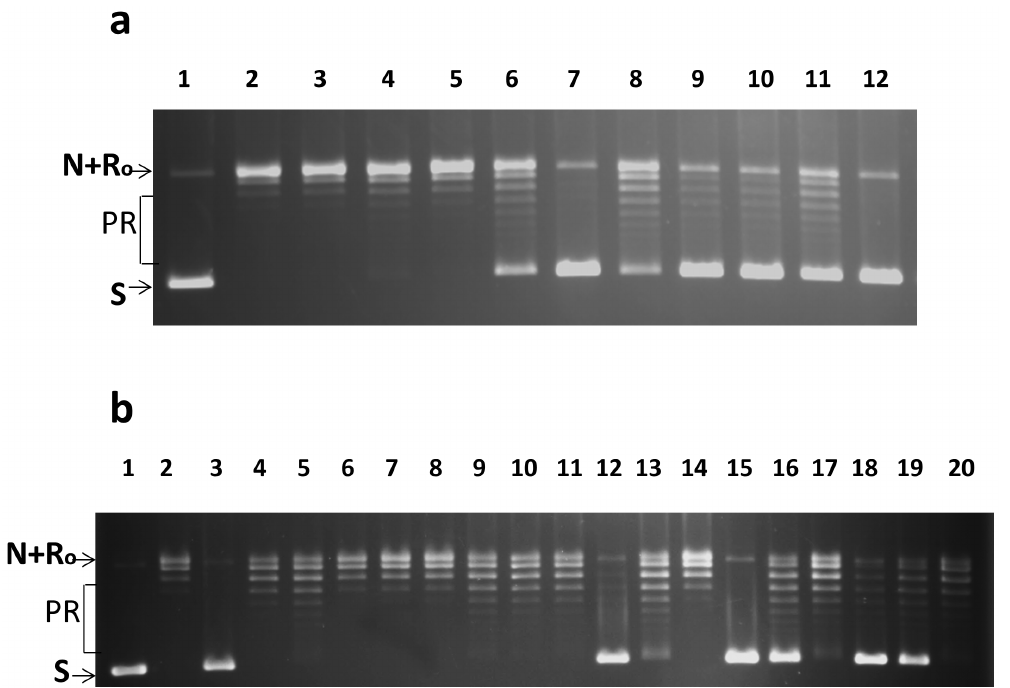
Figure 2. Inhibition of E.coli topoisomerase I relaxation activity by lichen extracts and fractions. (a) Secondary assay of natural product hits from HTS using negatively supercoiled DNA plasmid substrate. Lane 1: no enzyme. Relaxation activity of 10 ng of E. coli topoisomerase I was assayed in the presence of DMSO (lane 2) or 80 m g/mL of natural product extracts hits (lane 3–12). Extracts PL2050/C13 and PL2050/D12 prepared from lichen Hypotrachyna sp . samples were present in lanes 7 and 8 respectively. (b) Assay of HP20ss fractionated extracts of lichen Hypotrachynasp. samples. Lane 1: no enzyme control. Lane 2: Enzyme with DMSO control. Lanes 3–20: serial 4-fold dilutions (12, 3, 0.75 m g/mL) of unfractionated total extract (lanes 3–5), Fraction 1 (lanes 6–8), Fraction 2 (lanes 9–11), Fraction 3 (lanes 12–14), Fraction 4 (lanes 15–17), Fraction 5 (lanes 18–20). S: supercoiled plasmid DNA substrate. N: nicked plasmid DNA. Ro: Relaxed closed plasmid DNA. PR: partially relaxed plasmid DNA.